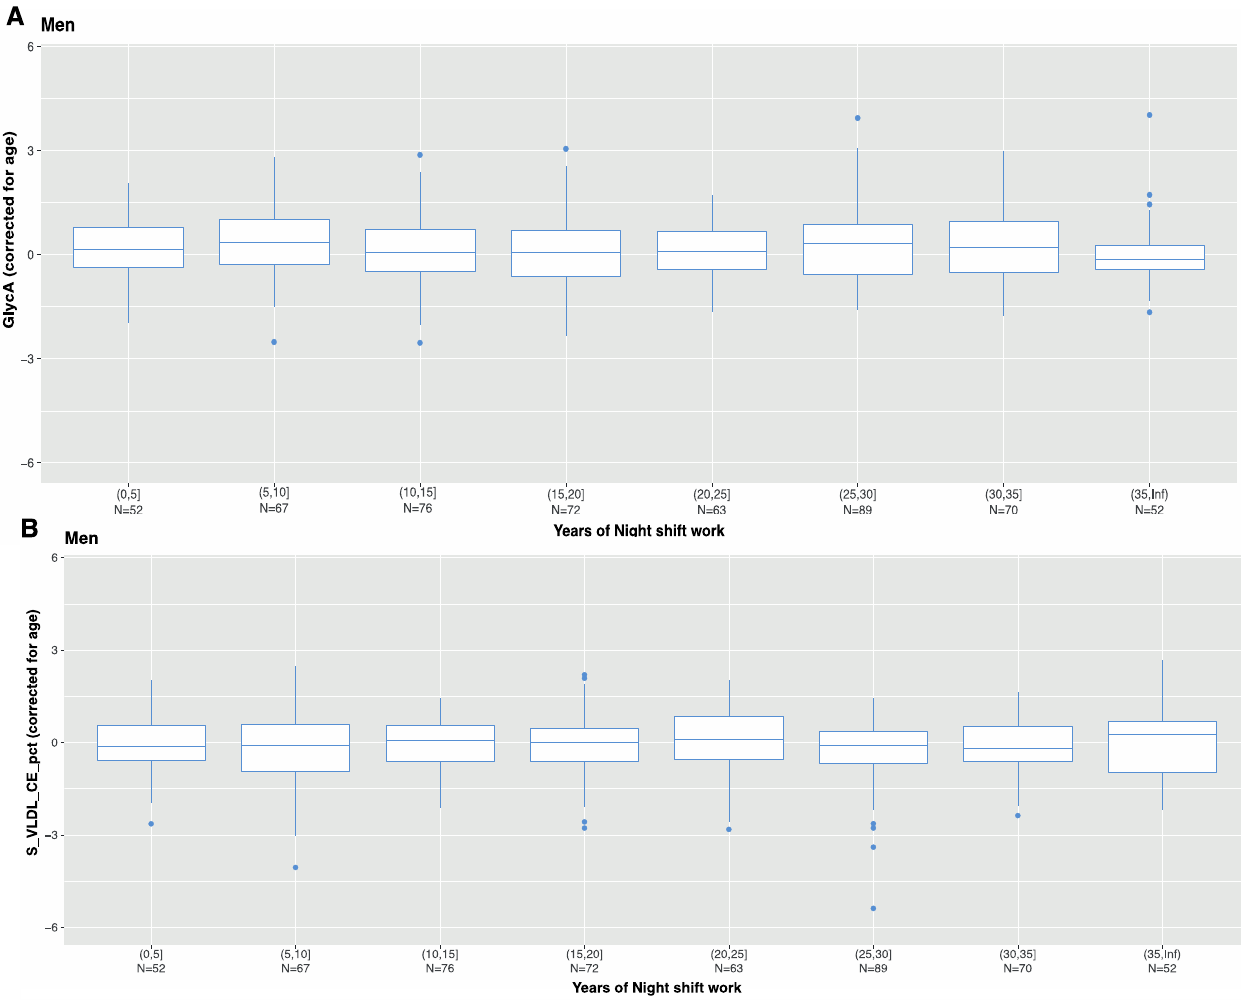
Figure 5. Residuals of ( A ) GlycA and ( B ) S_VLDL_CE_pct, after correcting for age among male